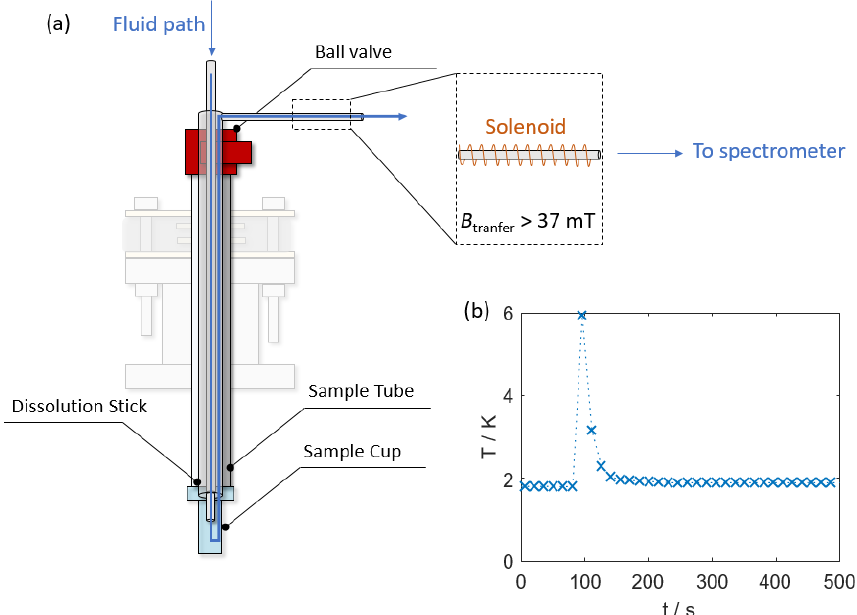
Figure 4. (a) Scheme of sample tube with dissolution stick inserted. The inlet for the hot D 2 O and the path the fluid takes is marked with a blue arrow. The outlet capillary exiting towards the detection spectrometer is surrounded by a solenoid to maintain a constant magnetic field during the sample transfer. Note that the magnetic field within the solenoid is perpendicular to the field of the DNP apparatus and the detection spectrometer. (b) Temperature profile during a dissolution experiment. During the dissolution, the temperature rises by 4K and subsequently returns to stand-by temperature within a